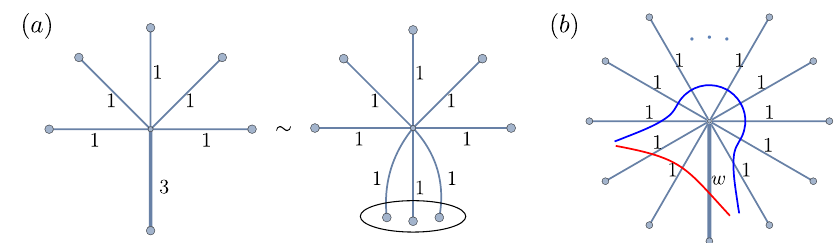
Fig. 1 Flower graphs are conjectured extremal rays of the cone of average entropies. a A fl ower graph with N ‘ petals ‘ of weight 1 and one ‘ stem ’ of weight w (here w = 3) can be obtained from a perfect tensor graph with N + w legs by bundling up w legs. b The entropy of each p -partite region in a fl ower graph is the smaller of two cuts (red and blue), which sever p or N + 1 −